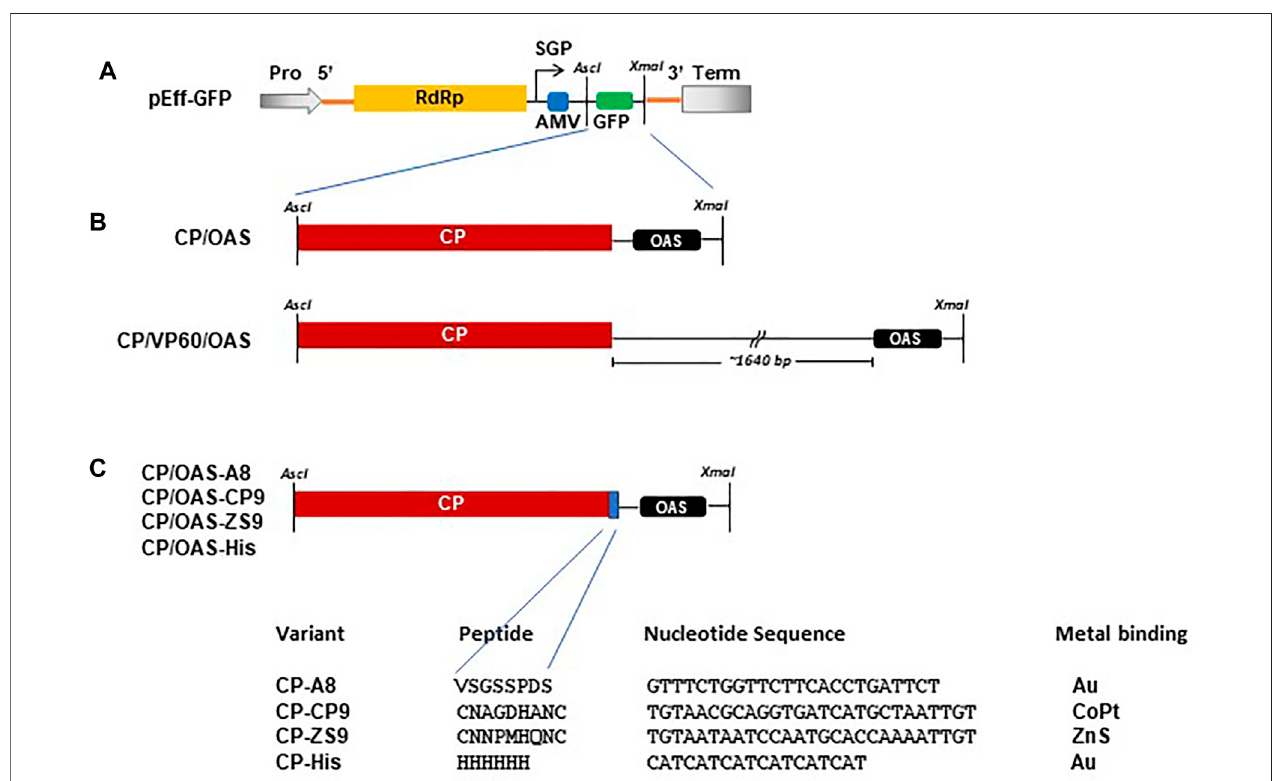
FIGURE1| Schematicofconstructsusedinthisstudy. (A) DiagrammaticillustrationofthepEffvectorshowingthe Asc Iand Xma Icloningrestrictionsiteslocatedin the subgenomic region. Pro, 35S promotor. Term, Nos transcription terminator. SGP, subgenomic promotor. Yellow box RdRp, blue box AMV leader sequence and green box, GFP. (B) Arrangementof TMV CPwith respect to theTMV OAS in CP/OAS and CP/VP60/OAS cloned intothe subgenomic region of the pEffvector in place of GFP. (C) Variant TMV CPs indicating the additional amino acid residues located at the TMV CP C-terminus, the additional nucleotide sequence and the target bound